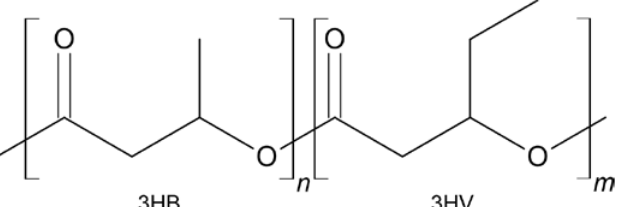
Figure 1. Representation of molecular structure of poly (3-hydroxybutyrate-co-3-hydroxyvalerate) (PHBV) (Drawn on ACD/ChemSketch Freeware, version 2019.2.1, Advanced Chemistry Development, Inc., Toronto, ON, Canada, www.acdlabs.com, 2020).